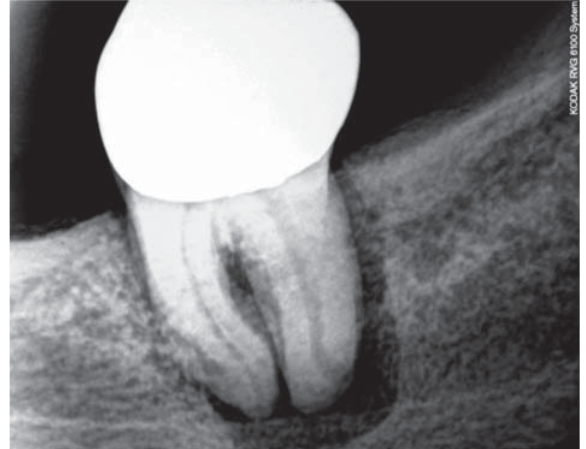
Figure 2- Radiographic image of tooth with periodontal endodontic